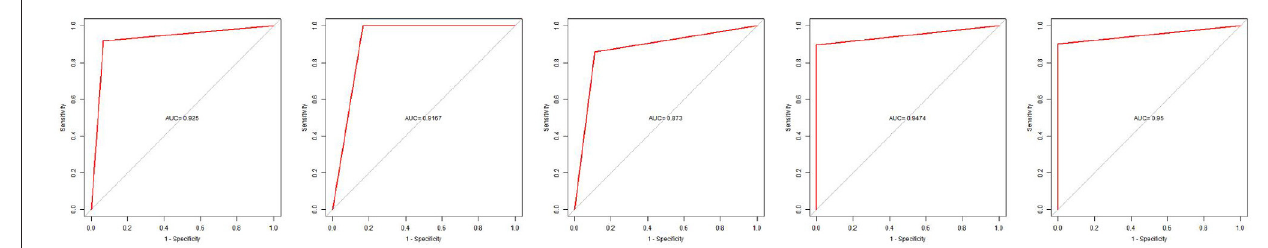
FIGURE 5 | Five-fold cross-validation verifies ROC curve results.